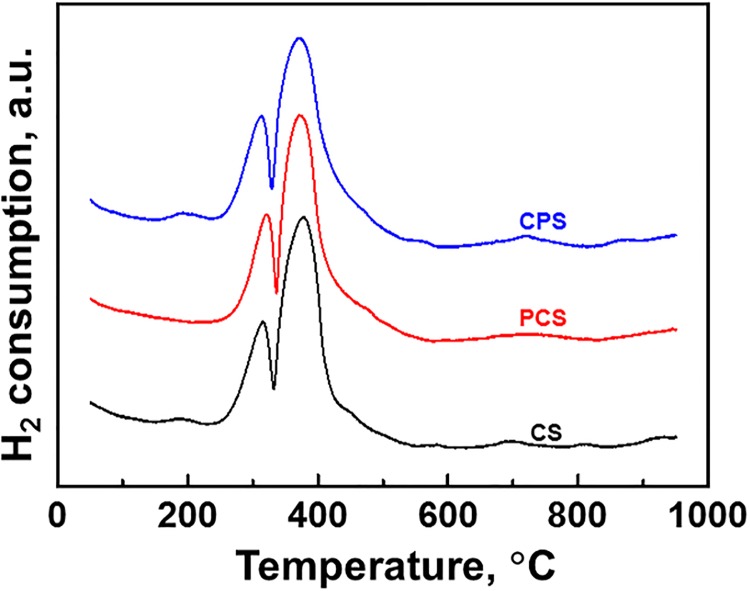
H2-TPR profiles of modified Co/SiO2 catalysts.5% H2/Ar, 24L/(h·g-cat), 10°C/min.